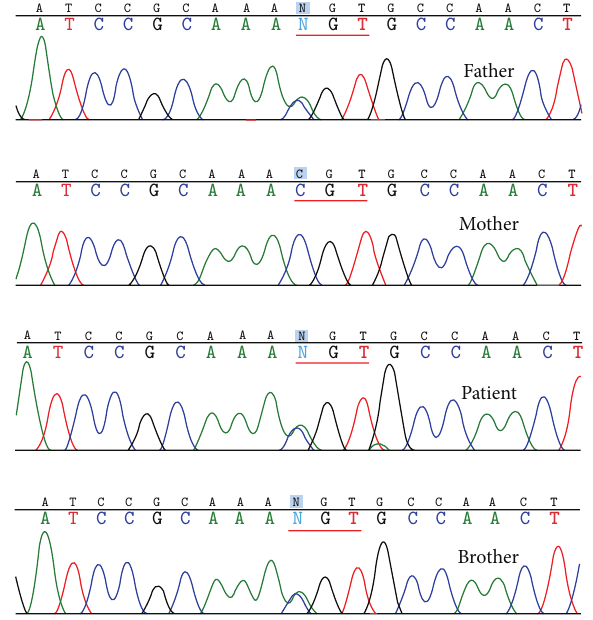
Figure 3: DNA sequence analysis. A c.125C > A substitution in the PROC sequence of the proband. The CGT encoding Arg42 at the processing cleavage site, which is recognized by the processing enzyme, is changed to AGT, encoding Ser. This mutation was also identified in her father and her younger brother but not in her